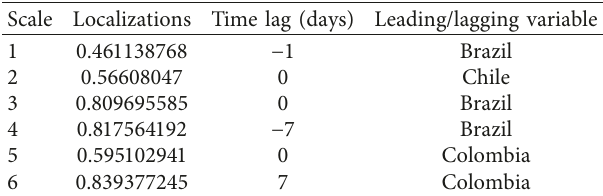
Table 4: Wavelet multiple cross correlations (WMCC). Scale Localizations Time lag (days) Leading/lagging variable